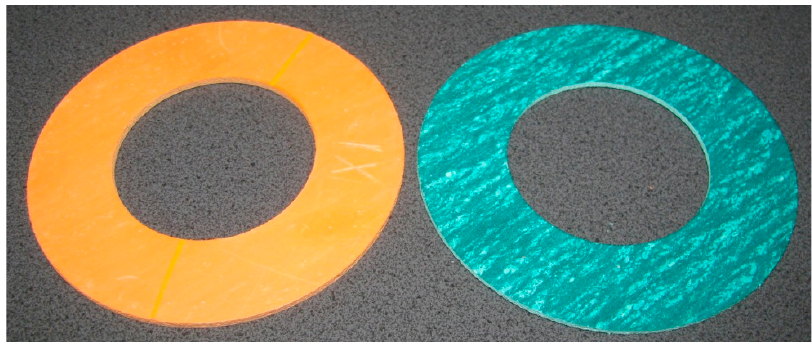
Figure 2. View of the tested gaskets; AFM—on the left, AFO—on the right. The AFO material is a multi-layer composite, with aramid and mineral fibers that improve strength and thermal resistance. NBR rubber plays the role of the binder, and fillers ensure tightness. The AFM material is a composite with aramid fibers with nanofillers and HNBR rubber. The materials of the mentioned gaskets are suitable for classic fuels.